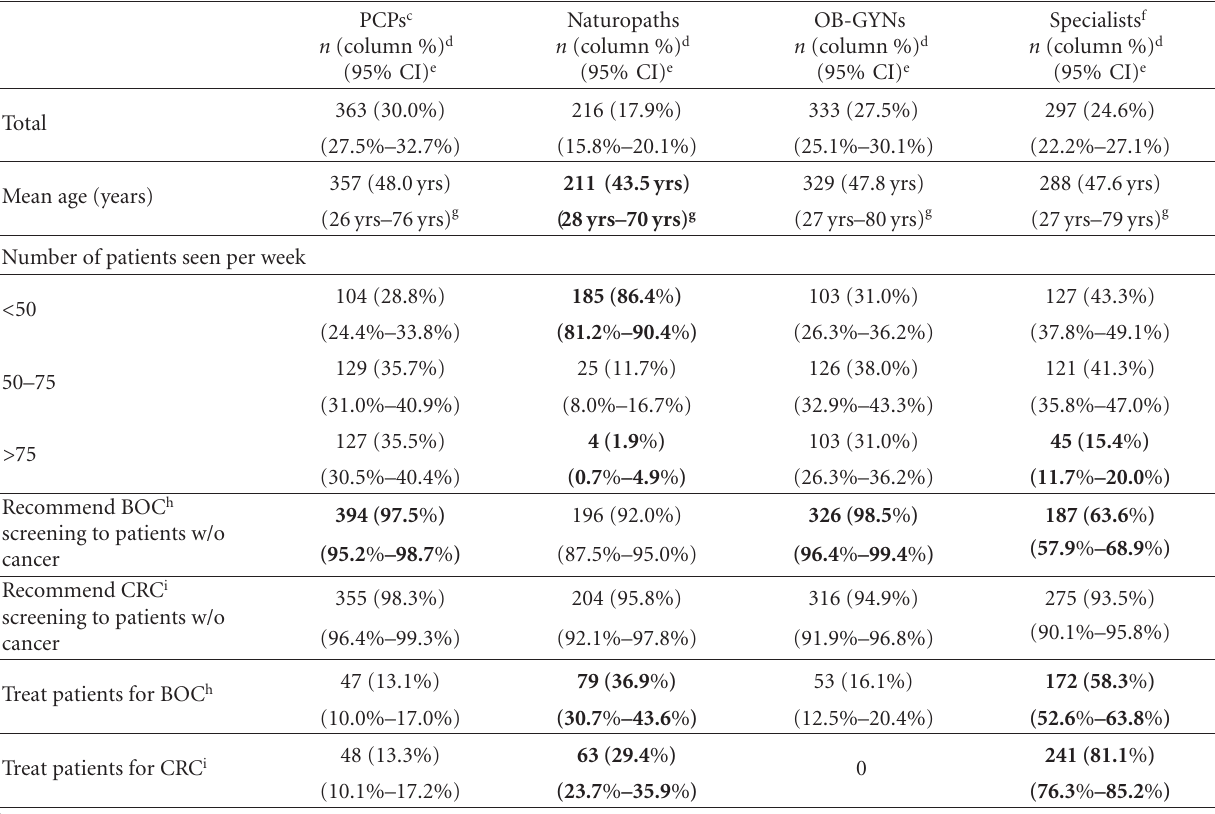
Table 2: Summary data from the 2010 Oregon Health Care Provider Survey, by provider